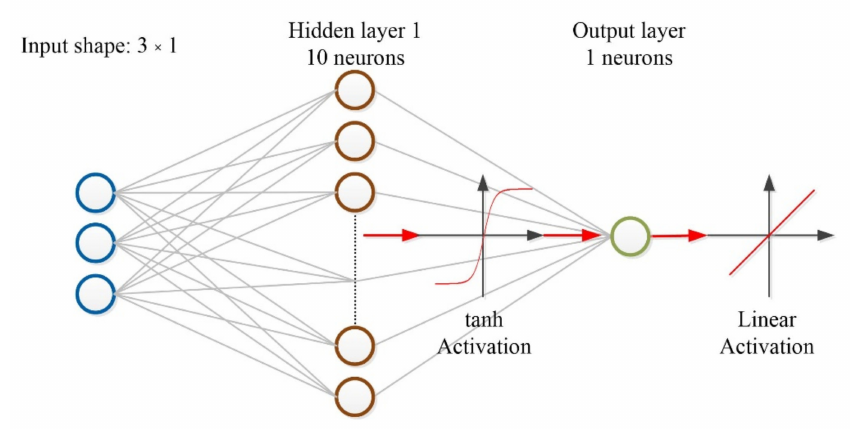
Figure 10. Architecture of the BPNN.